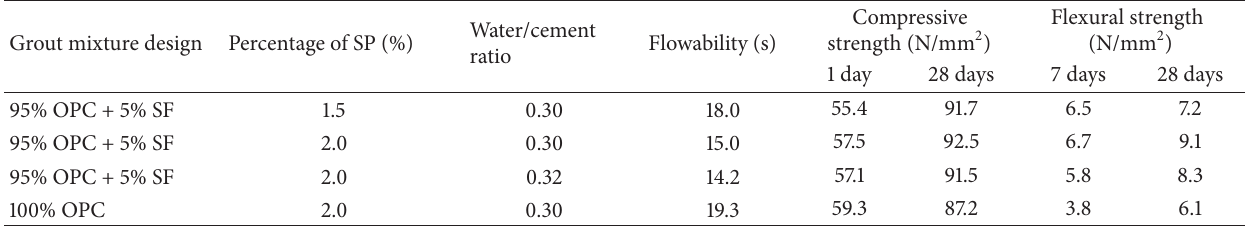
Table 3: Selected designs and flexural strength of cementitious grout